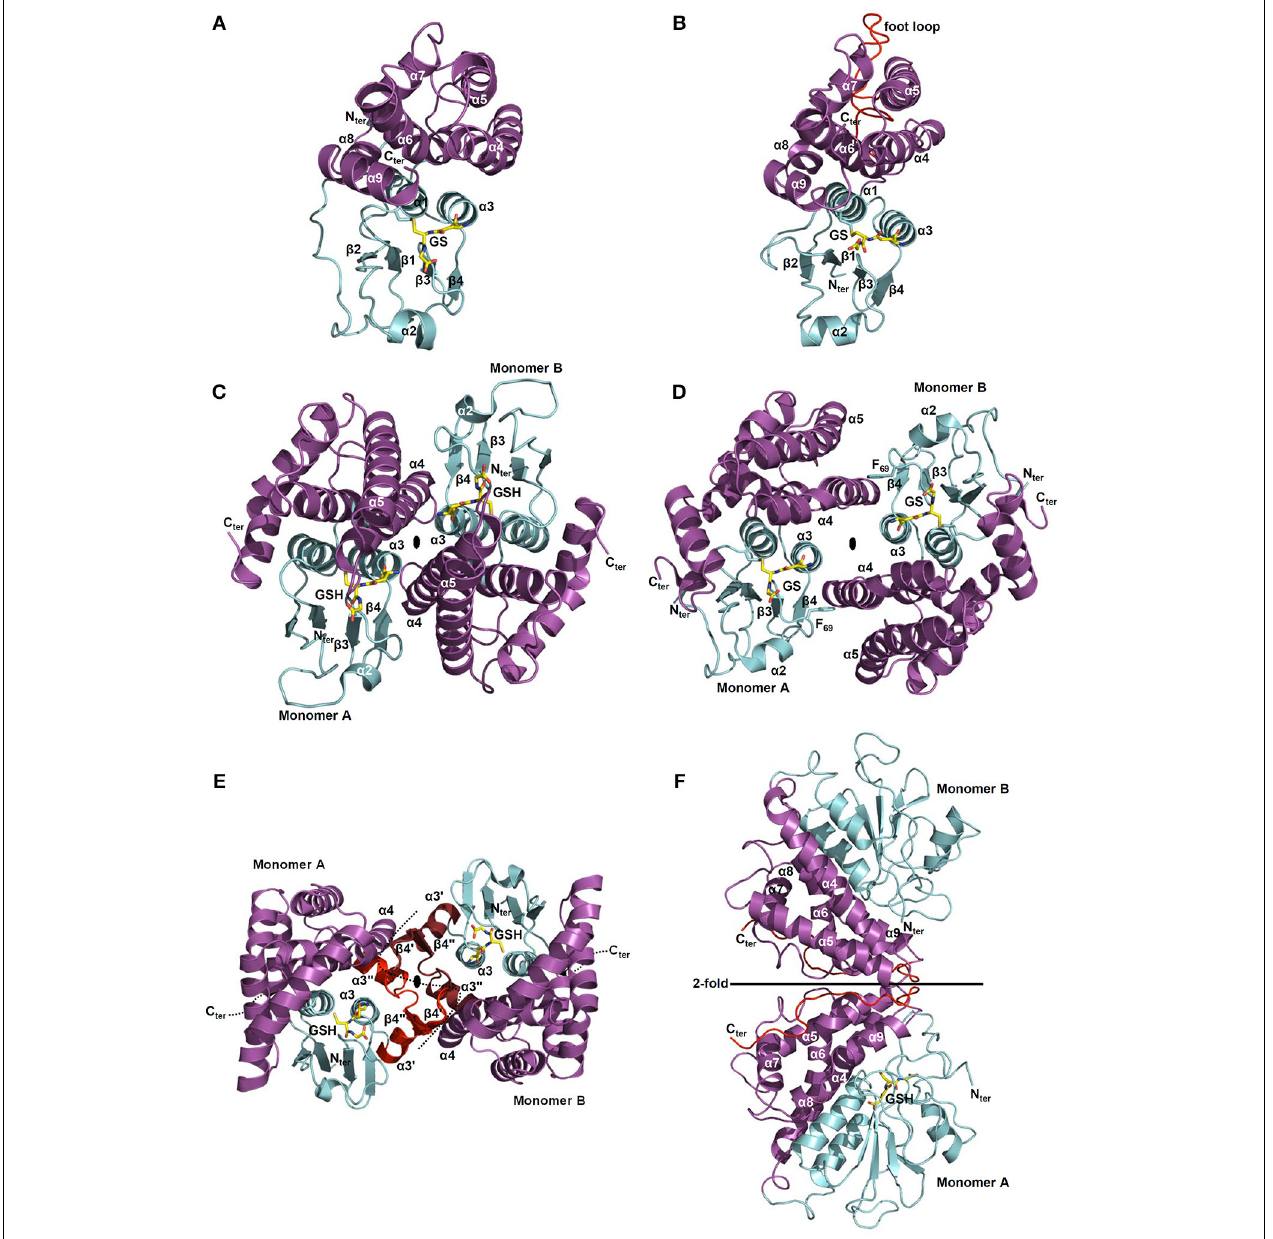
FIGURE 5 | Structural organization of Cys-GSTs. All structures are shown as cartoon with the N- and C-terminal domains colored in cyan and in purple, respectively. Glutathione (GSH) or glutathione adducts (GS) are represented as sticks. In F , glutathione is only present in monomer A. All figures have